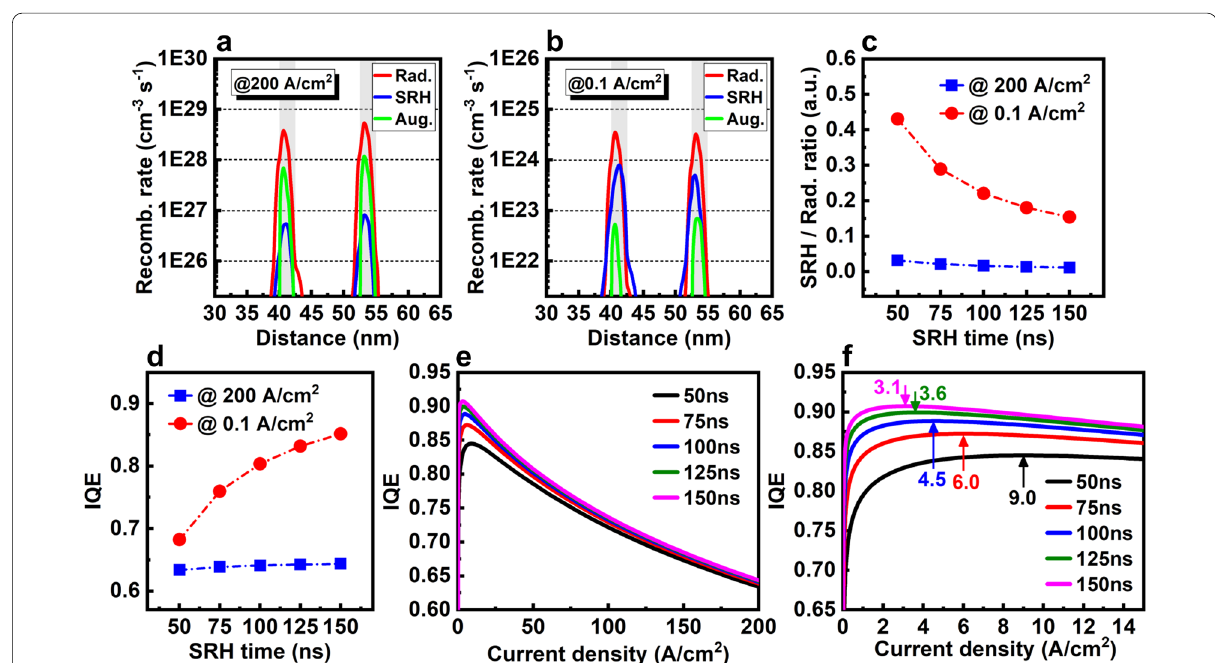
Fig. 10 Radiative, SRH, and Auger recombination rates of 2QWs LED a at 200 A/cm 2 and b at 0.1 A/cm 2 . c SRH/Radiative ratio with various SRH lifetimes at 200 and 0.1 A/cm 2 . d IQE values at 200 and 0.1 A/cm 2 , e IQE curves with large current density and f IQE curves with low current density at various SRH